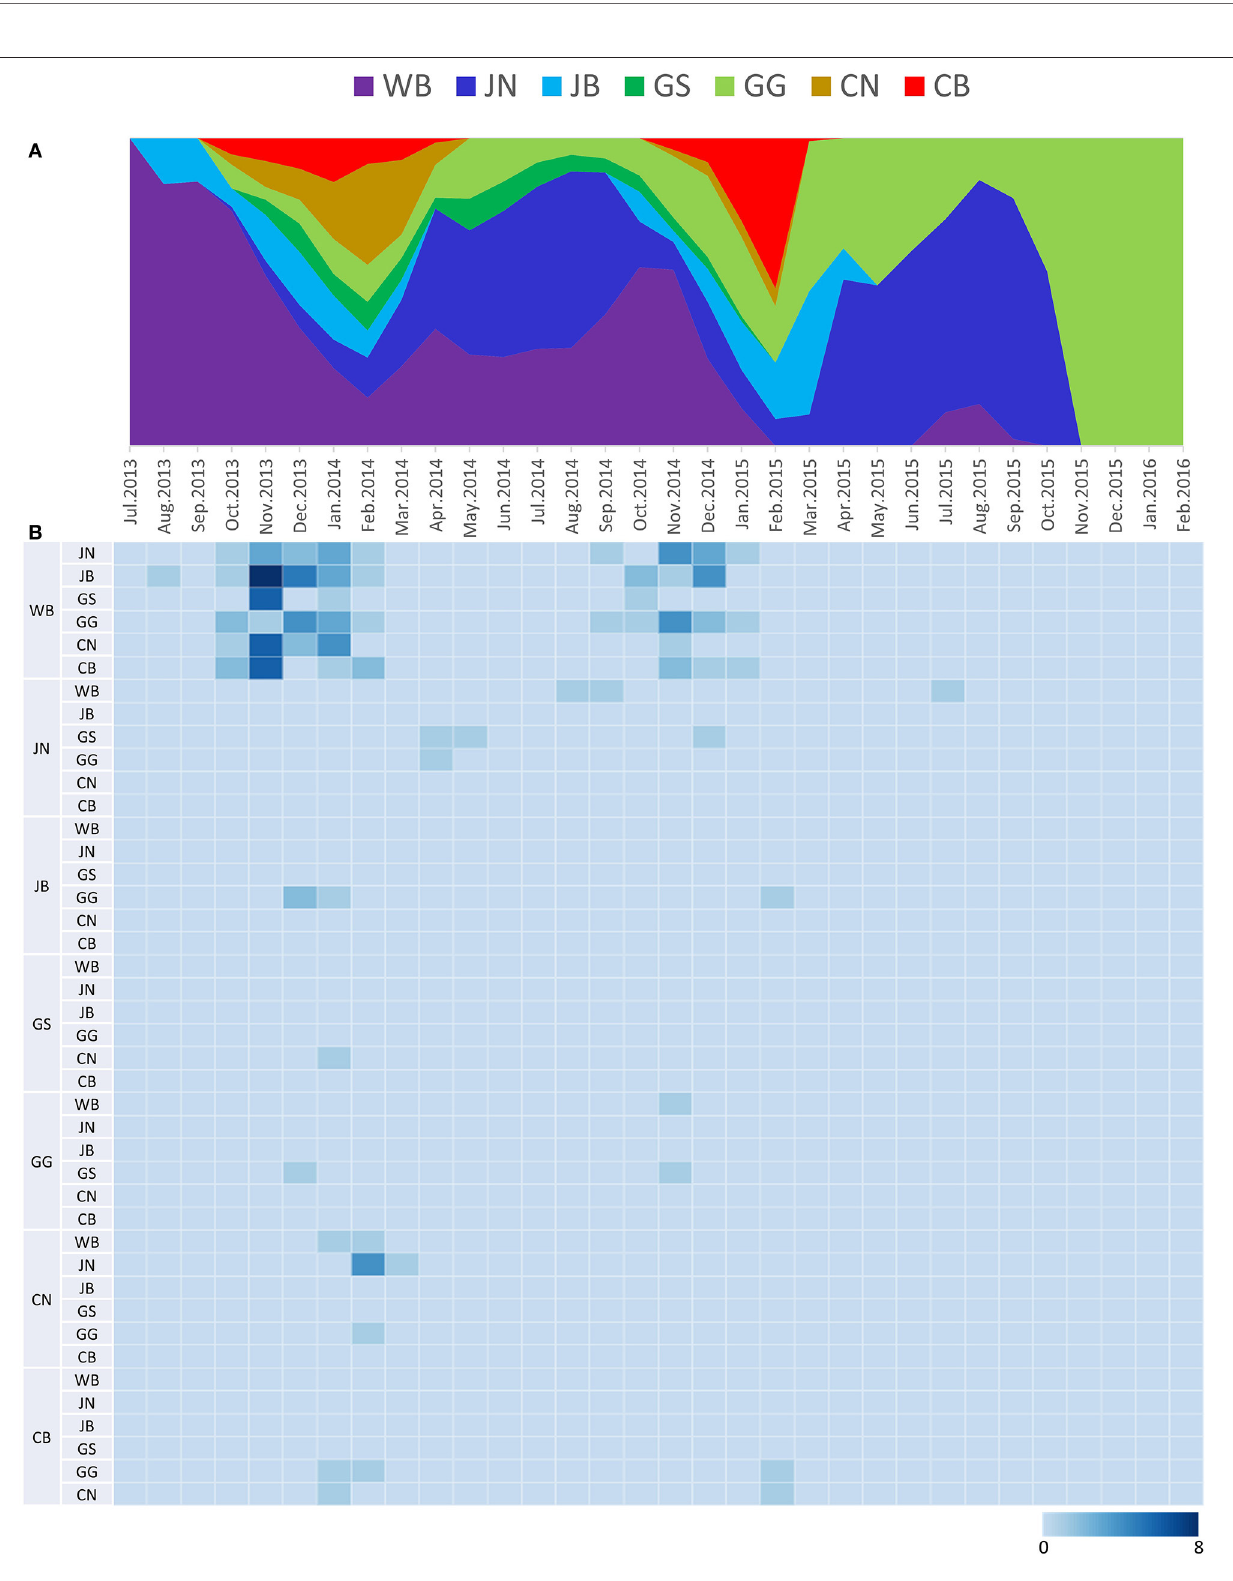
Frontiers in Veterinary Science |